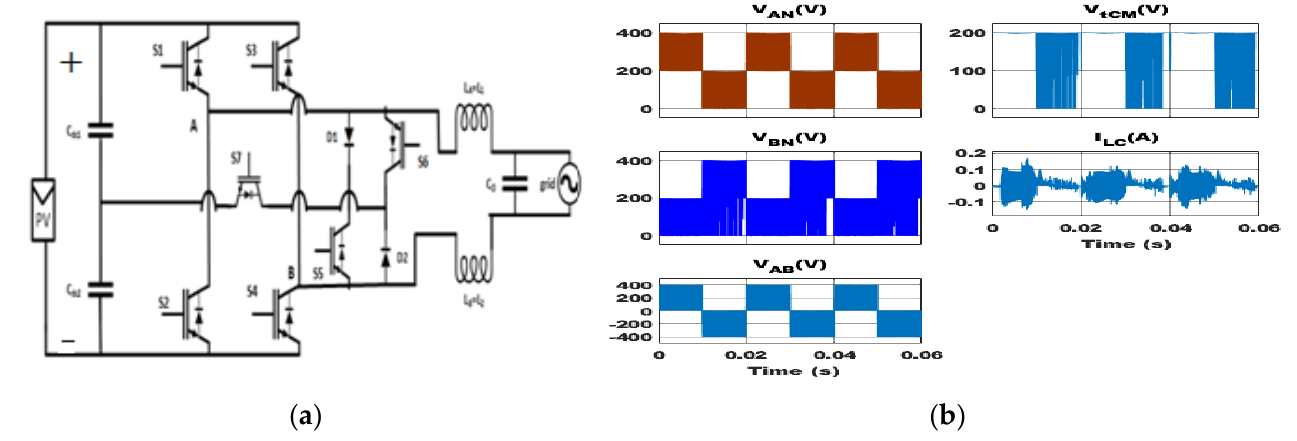
Figure 16. HERIC Active-I topology: ( a ) circuit structure; ( b ) simulation results.